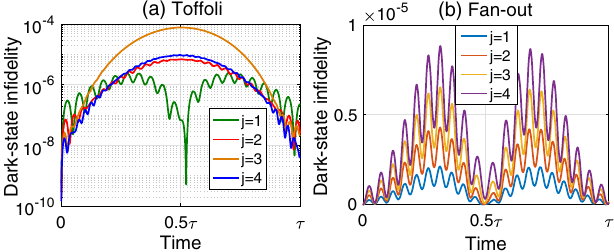
FIG. 3. The infidelity of the numerical solution to the time- dependent Schrödinger equation with respect to the time- ffiffiffiffiffiffiffiffiffiffiffiffiffiffiffiffiffiffiffiffiffiffiffiffiffiffiffi p ffiffiffiffi p dependent dark eigenstate (2) for the Toffoli gate (a), and (4) m ð j − m þ 1 Þ Ω = 2 ; m B t 1 (cid:2) ffiffiffiffi for the fan-out gate (b). The Rydberg qubit states are j 101 S; 109 S i , p m B 1 (cid:2) for odd and with interaction strengths listed in Table I in Appendix A. The target Gaussian 2 π pulse with duration τ and maximum Rabi frequency Ω t ¼ 0 . 1 B 1 is applied to atoms on a square latticewith a lattice constant of 10 μ m. The atomic system is chosen to maximize the values of B 1 and minimize the ones of B 2